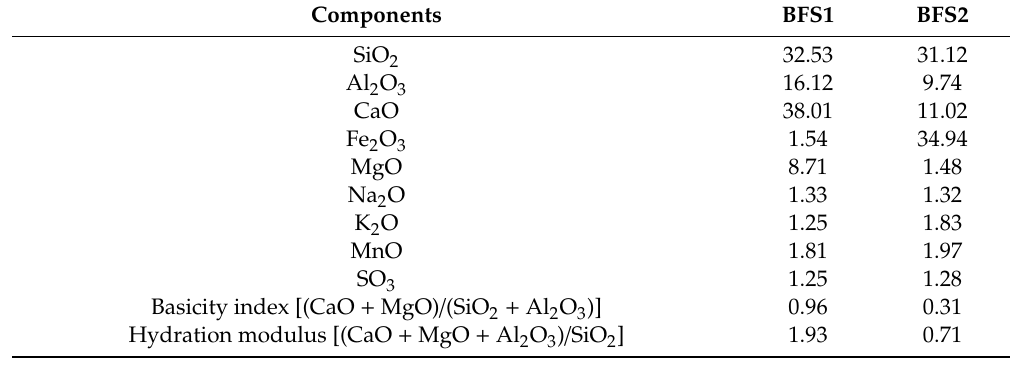
Table 1. Chemical composition of blast furnace slags (BFS) (wt.%).